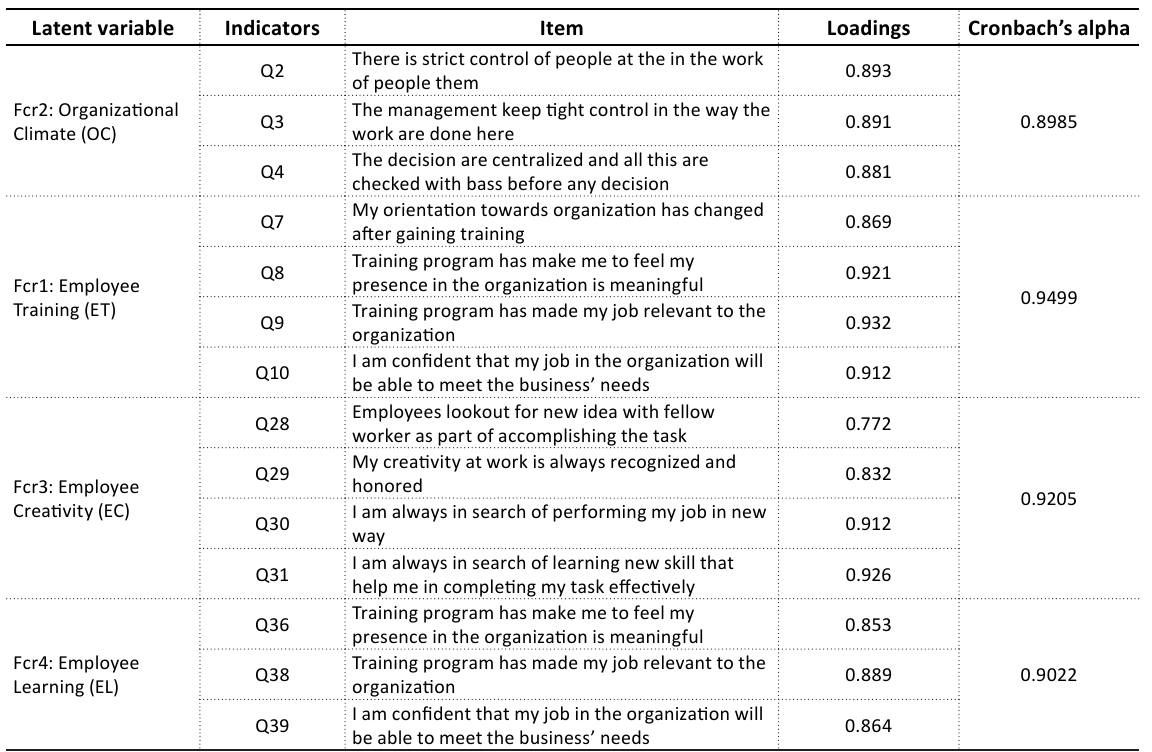
Table 3. Factor loadings with item details and construct’s alpha